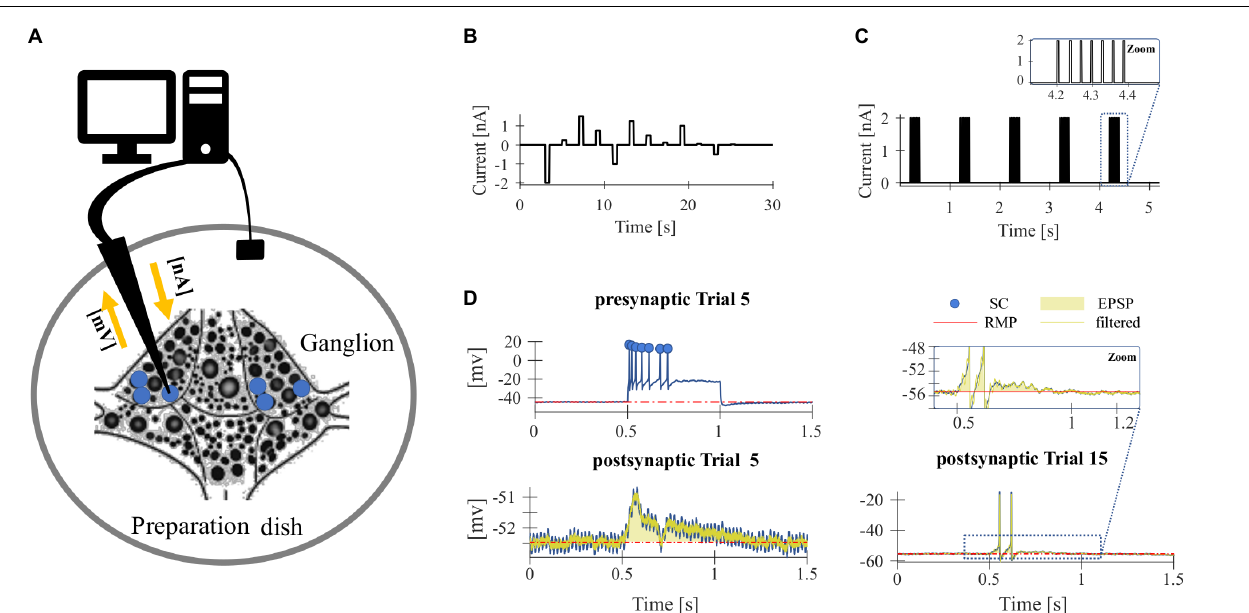
FIGURE 1 | Experimental design. (A) Sketch of the isolated ganglia preparation and the principle of the current-clamp recording. The membrane potential of one of the T cells (blue) was recorded with an intracellular electrode (black arrow). (B,C) Stimulus protocol for repeated electrical soma stimulation. Each experiment consisted of 15–20 identical trial repetitions. (B) For the experiments presented in Figures 2 , 4A,B , 12 electrical pulses of different current amplitudes were injected into the T cell soma. (C) For studying synaptic interaction of T cells ( Figures 4C–F ), five pulse packages were injected into the soma if one T cell. Each package contained a fixed number (1–7) of pulses that elicits the same number of single action potentials. The zoom inset shows a package with 7 pulses. (D) The neuronal responses were quantified by the following features: (presynaptic) spike count (SC, blue dots indicate counted spikes): total number of spikes elicited by the neuron and recorded in the soma between the stimulus onset (0.5 s) and offset (1 s); resting membrane potential (RMP, red): averaged membrane potential in the 2.5 s prior to the first current pulse; postsynaptic response (PR): averaged difference between the filtered recorded membrane potential and the RMP calculated from the start to 200 ms after the end of the presynaptic current stimulus (yellow transparent area). Synaptic potentials sometimes triggered spikes in the postsynaptic cell (see Trial 15 for an example), but not in all (see Trial 5 for an example). The calculation of PR included spikes if they were